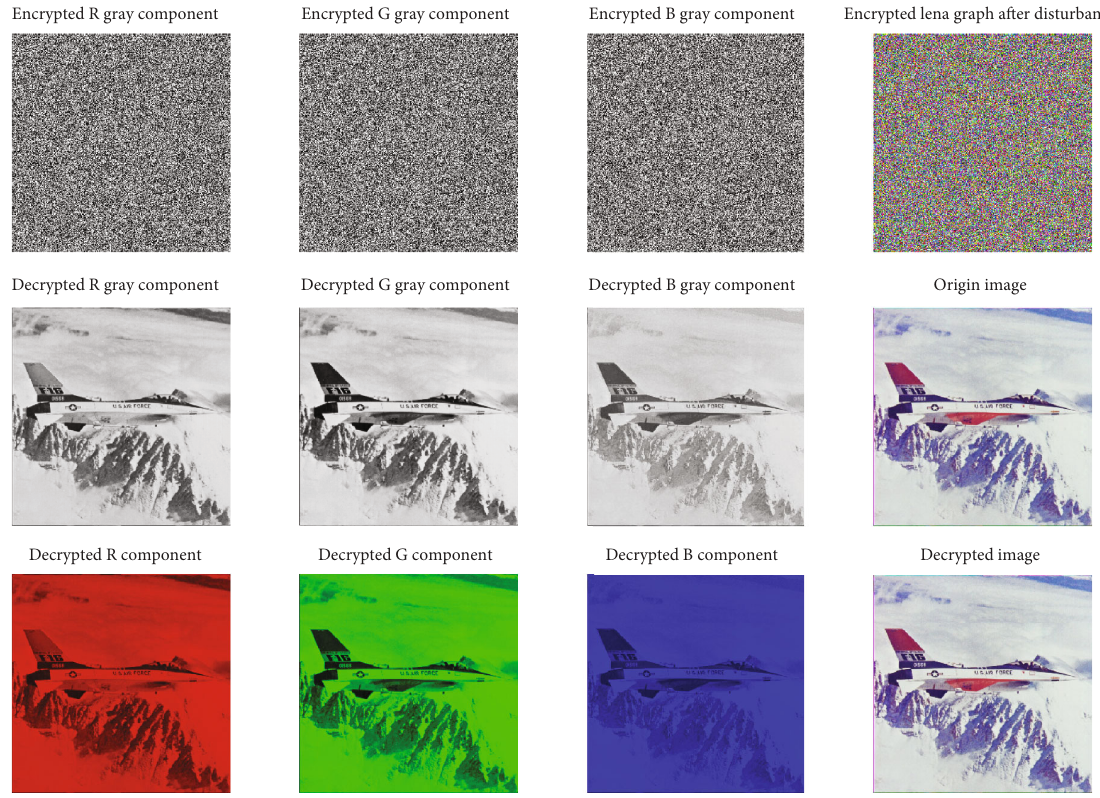
Figure 4: Airplane ciphertext component